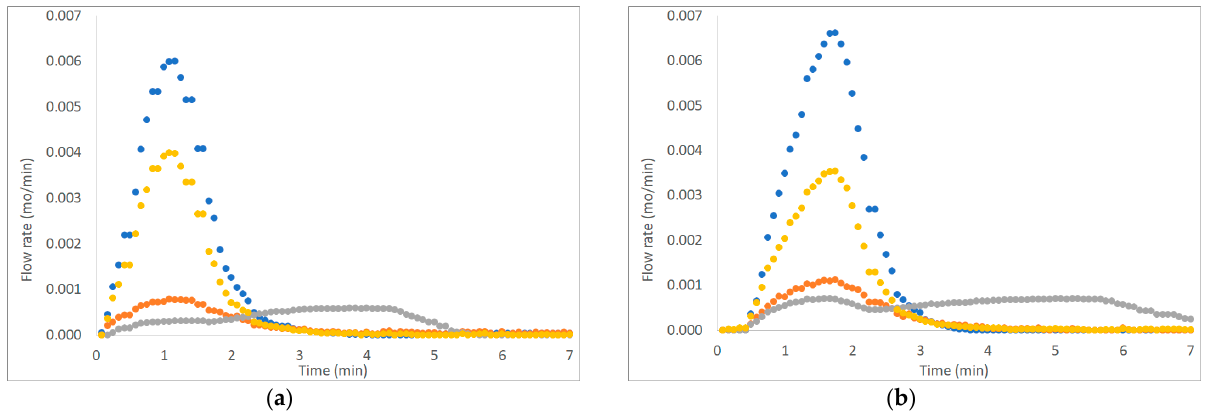
Figure 5. Example of H 2 , CO, CO 2 , and CH 4 outlet molar flow rates ( F i , out ) as functions of time ( t ), produced by devolatilization tests of ( a ) wet chirurgical masks and ( b ) wet FFP2 mask, in a fluidized bed reactor at 700 °C, in nitrogen and air atmosphere. ( ● H 2 , ● CO, ● CO 2 ; ● CH 4 ).